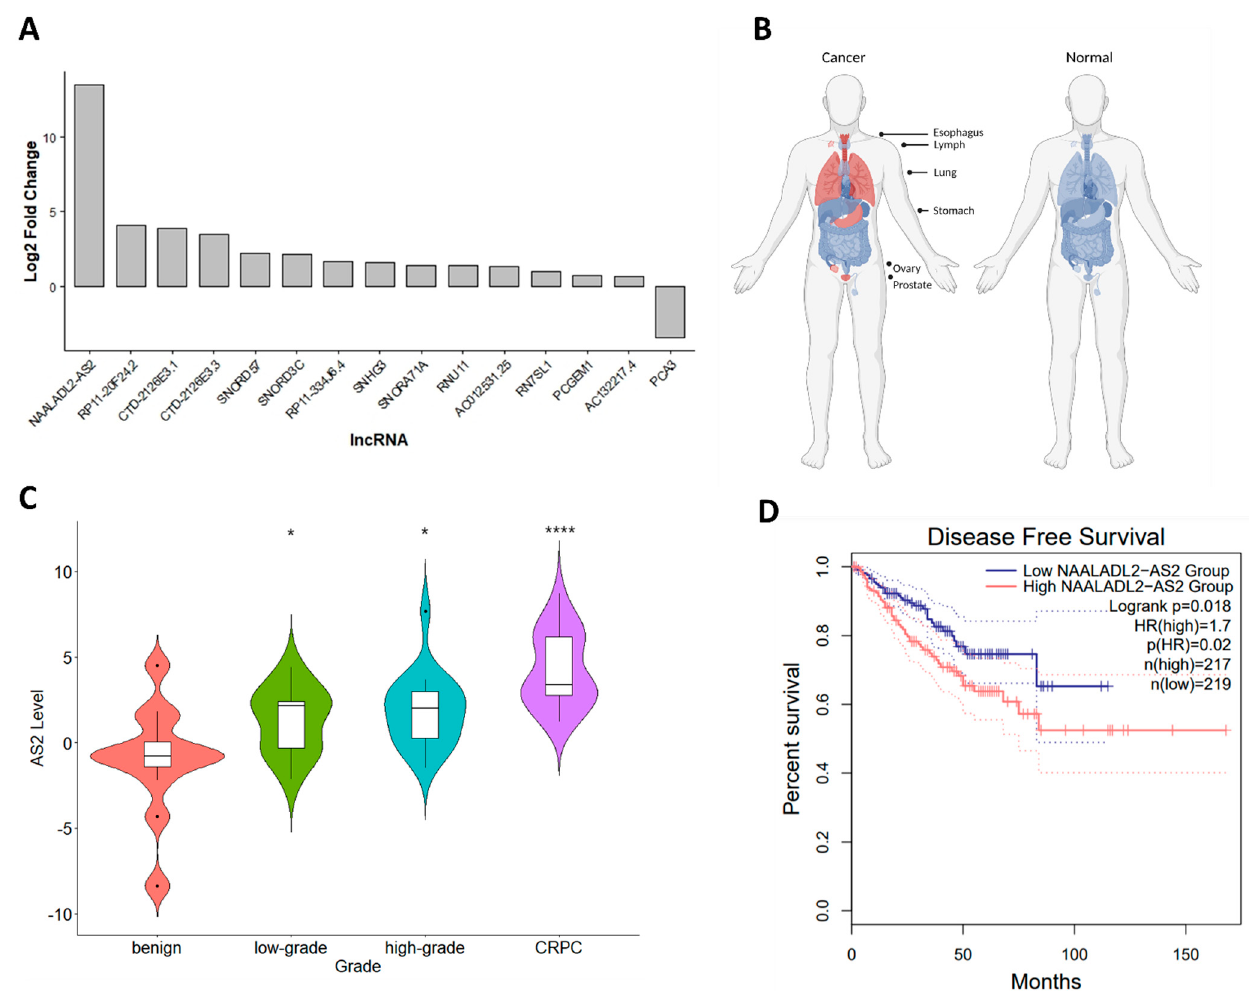
Figure 1. The expression of AS2 in CRPC versus HSPC ( A ). Graphical representation of AS2 expression (red) in various malignant (left, TCGA data) and non-malignant (right, GTEx data) accessed via GEPIA2 [12], stylized using BioRender.com ( B ). AS2 expression as determined by qPCR in benign, hormone sensitive low-grade PCa (Gleason score < 7), hormone sensitive high-grade PCa (Gleason score ≥ 7), and CRPC. Pairwise means comparison against the benign group was done using a T -test, *: p < 0.05, ****: p < 0.0001. ( C ). Kaplan Meier survival analysis of HSPC patients with high and low tumor AS2 expression (median cut off) (PRAD TCGA data) [12] ( D ).